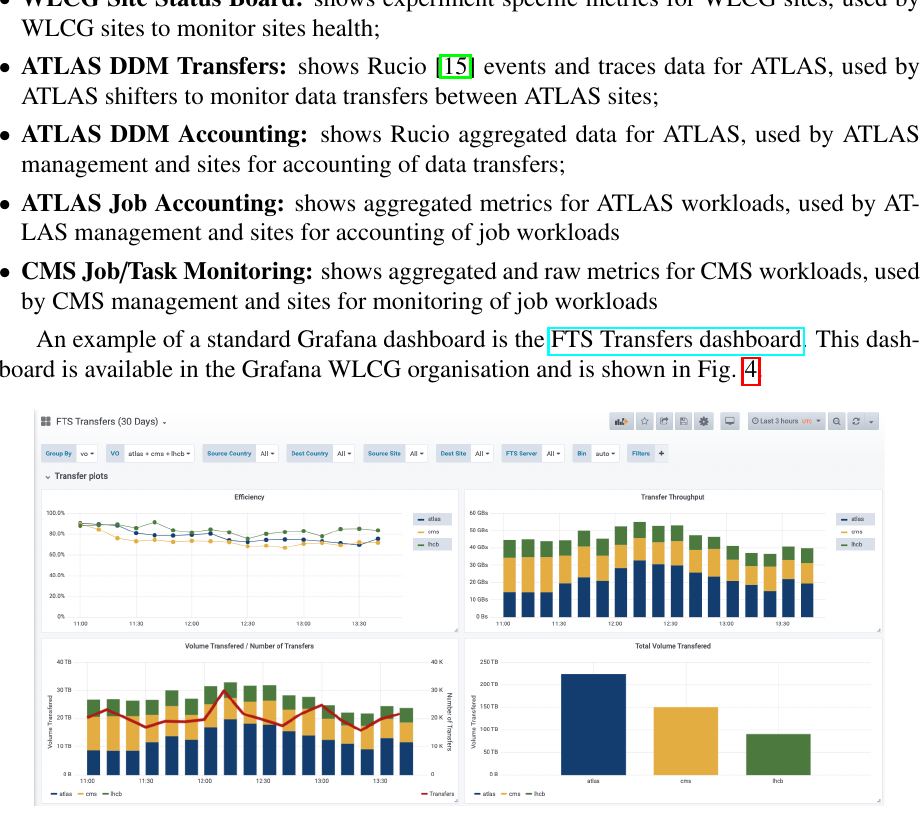
Figure 4: Grafana dashboard example - FTS Transfers